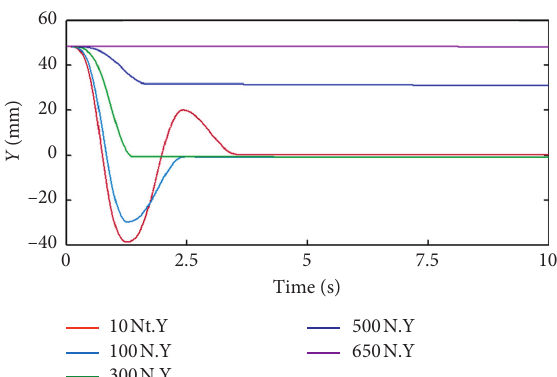
Figure 13: The oscillation curve of the center of mass of the platform in Y direction when β � ( π /20 ) and ϕ � ( π /2 ) under different loads between the upper and lower disc